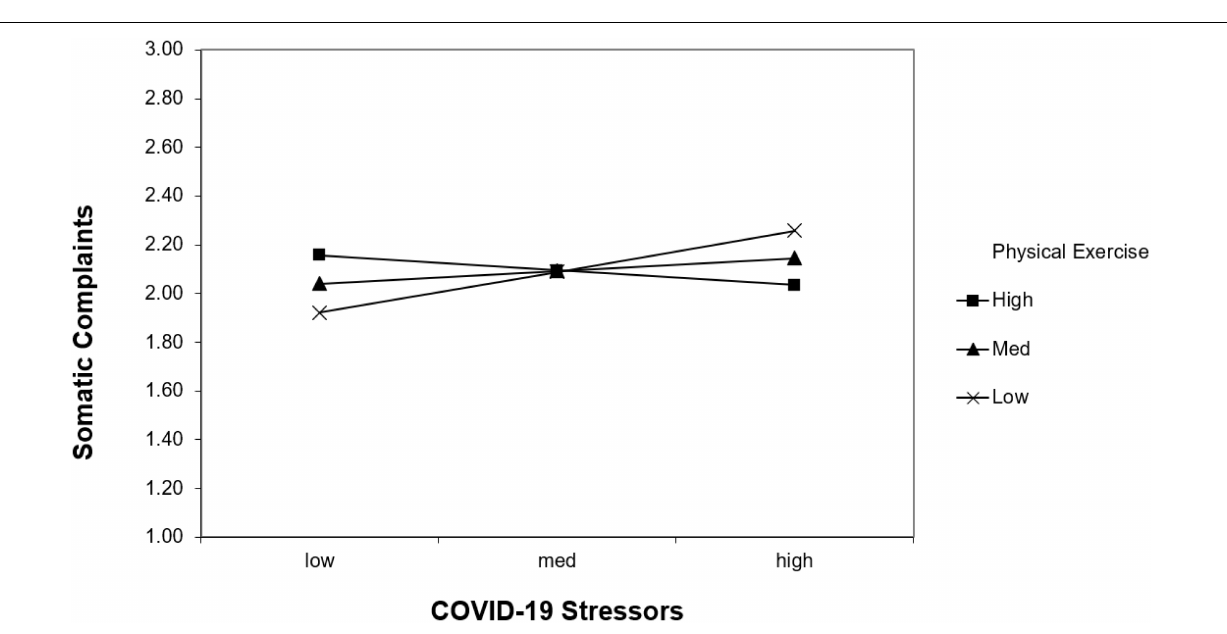
FIGURE 2 | Interaction effect of the COVID-19 stressors and physical exercise on somatic